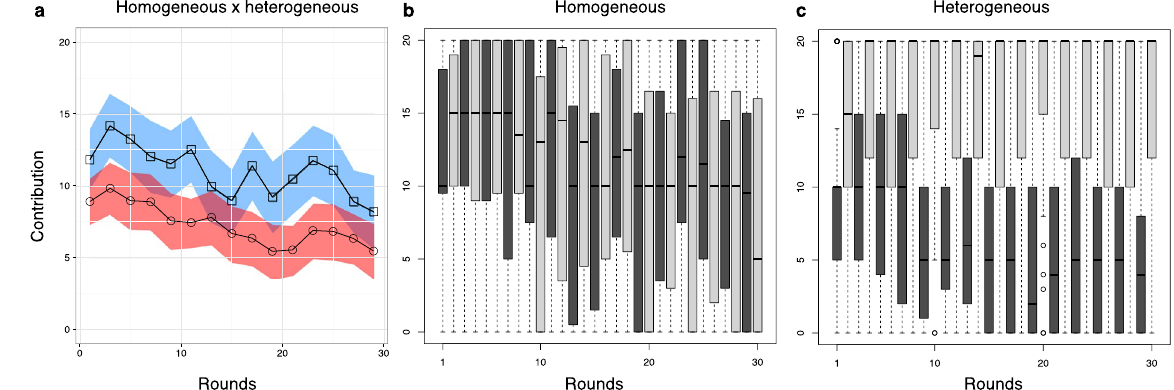
Figure 1. Contributions in all rounds for both treatments. ( a ) Average contribution per round in the homogeneous treatment (☐, blue) and in the heterogeneous treatment ( ○ , red) for r = 2. The average contribution in social dilemma games is lower in the heterogeneous treatment than in the homogeneous one. The shaded area defines the 95% confidence interval about the mean. To focus on rounds with r = 2, only data for the odd rounds is shown. The ( b ) box plot for the contribution in the homogeneous and c in the heterogeneous treatment. Odd rounds are shown in dark grey and even ones in light grey in the box plots.